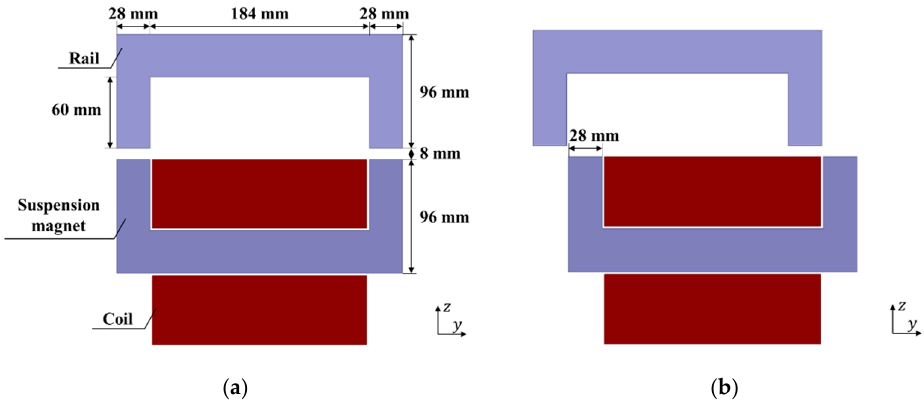
Figure 3. Two-dimensional simulation model diagram with horizontal misalignment. ( a ) ∆𝑦(𝑡) = 0 ; ( b ) ∆𝑦(𝑡) = 2𝑎 . ( b ) ∆ y ( t ) = 2 a